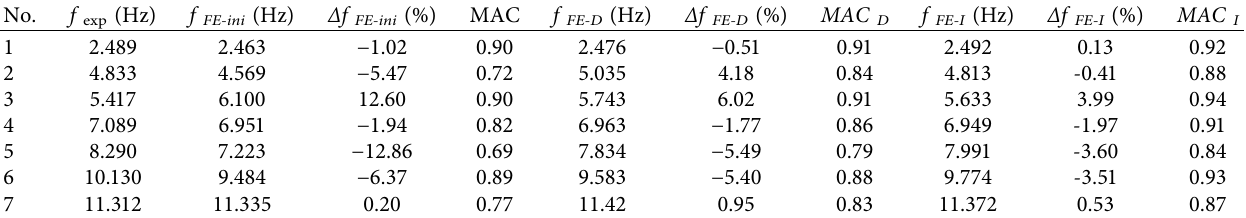
Figure 6: Results of the sensitive analysis of the selected parameters. Table 3: Numerical modal results in comparison to the experimental